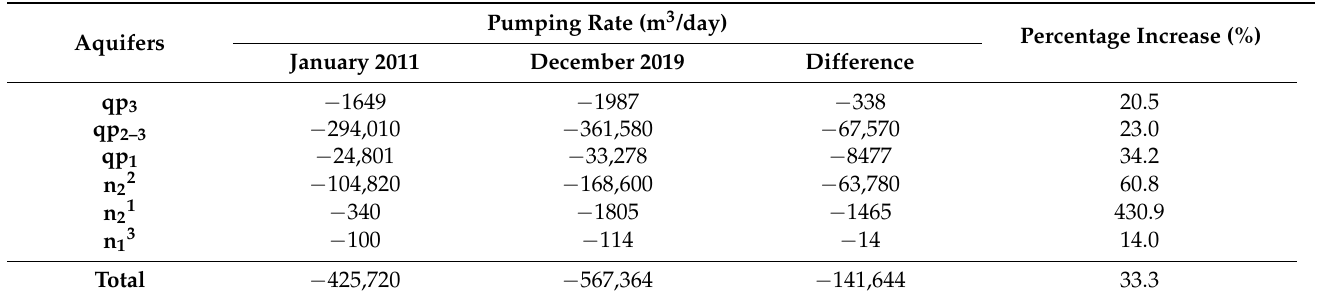
Table 2. Total pumping rates in the model for different